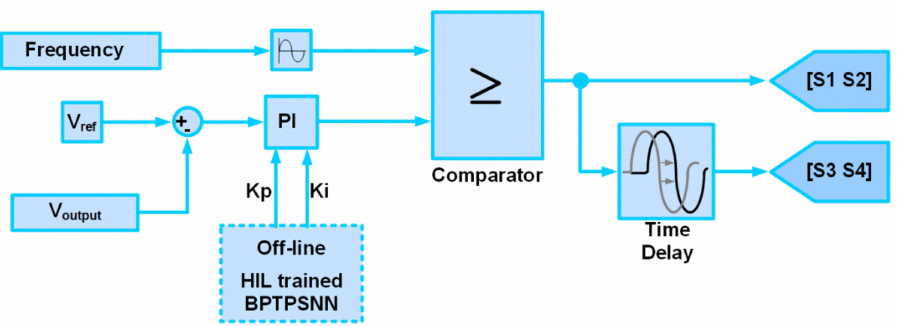
Figure 8. Functional diagram of the QWS controller.